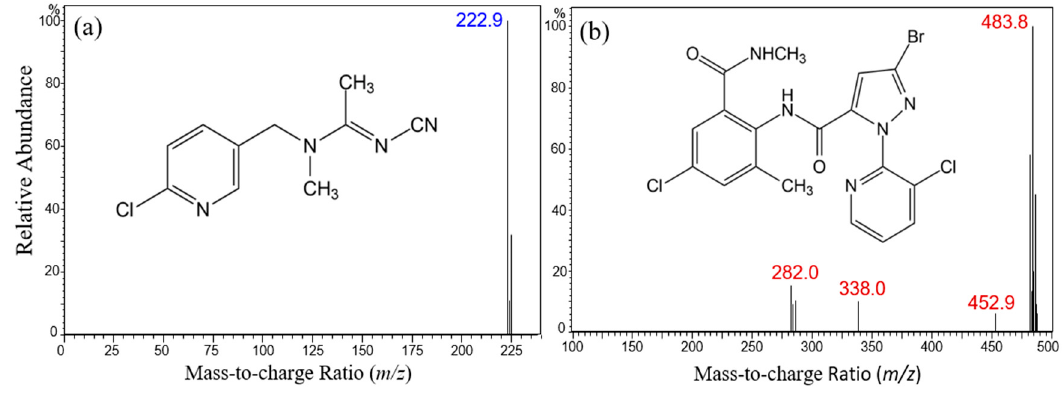
Figure 1. Chemical structures and the mass spectrometry (MS) full-scan spectrum of acetamiprid ( a ) and chlorantraniliprole ( b ).